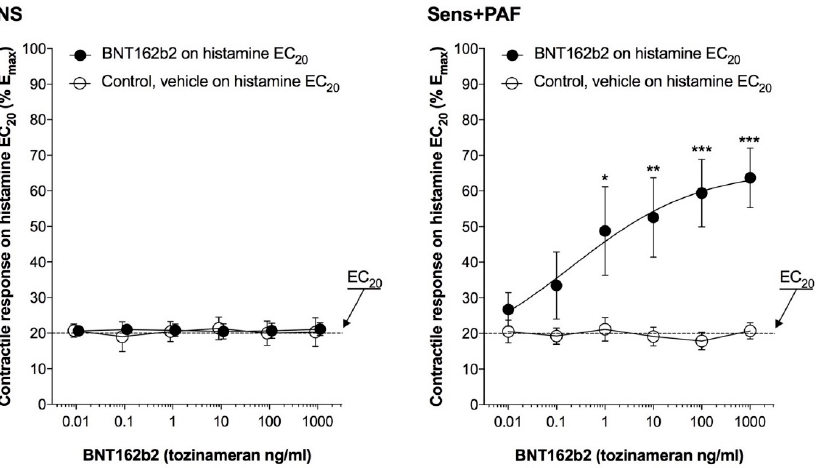
Figure 2. Effect of BNT162b2 in NS and sens+PAF isolated airways partially pre-contracted by his- tamine. * p < 0.05, ** p < 0.01, and *** p < 0.001 vs. control; results reported as mean ± SE of n = 5 human isolated sub-segmental bronchi. EC 20 : concentrations eliciting 20% the maximal effect; NS: non-sensitized; PAF: platelet-activating factor; SE: standard error; sens+PAF: passively sensitized plus PAF challenge.